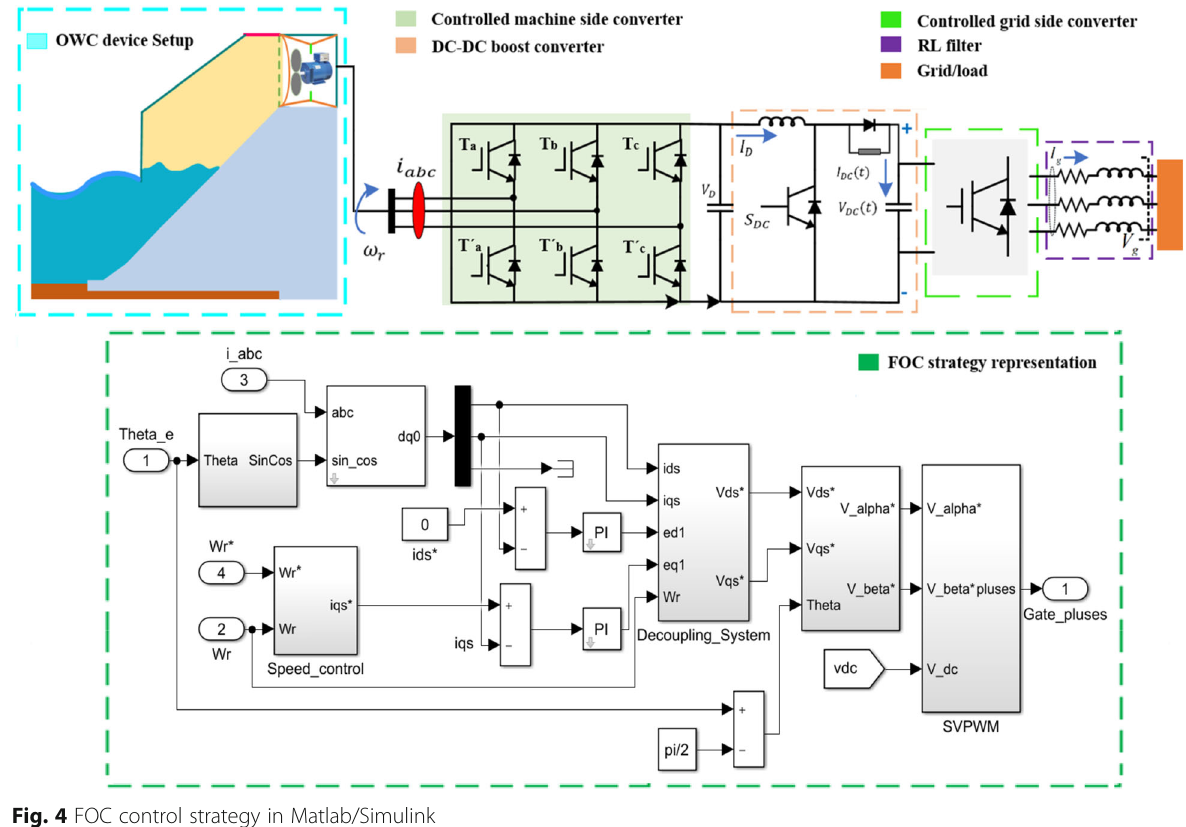
Fig. 4 FOC control strategy in